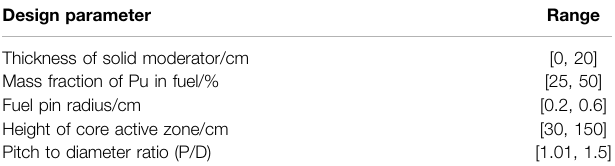
TABLE 3 | Range of design parameters for